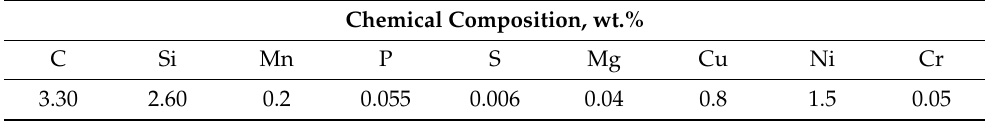
Table 3. Chemical composition.